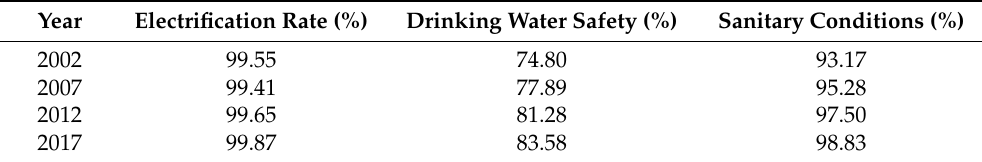
Table 6. Representative information on rural areas in Central Asia.